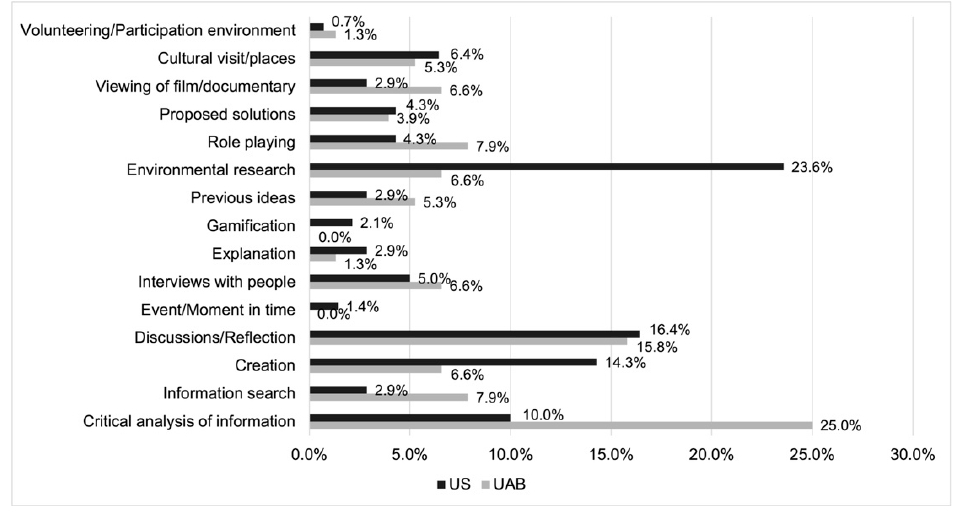
Figure 4. Types of activities.